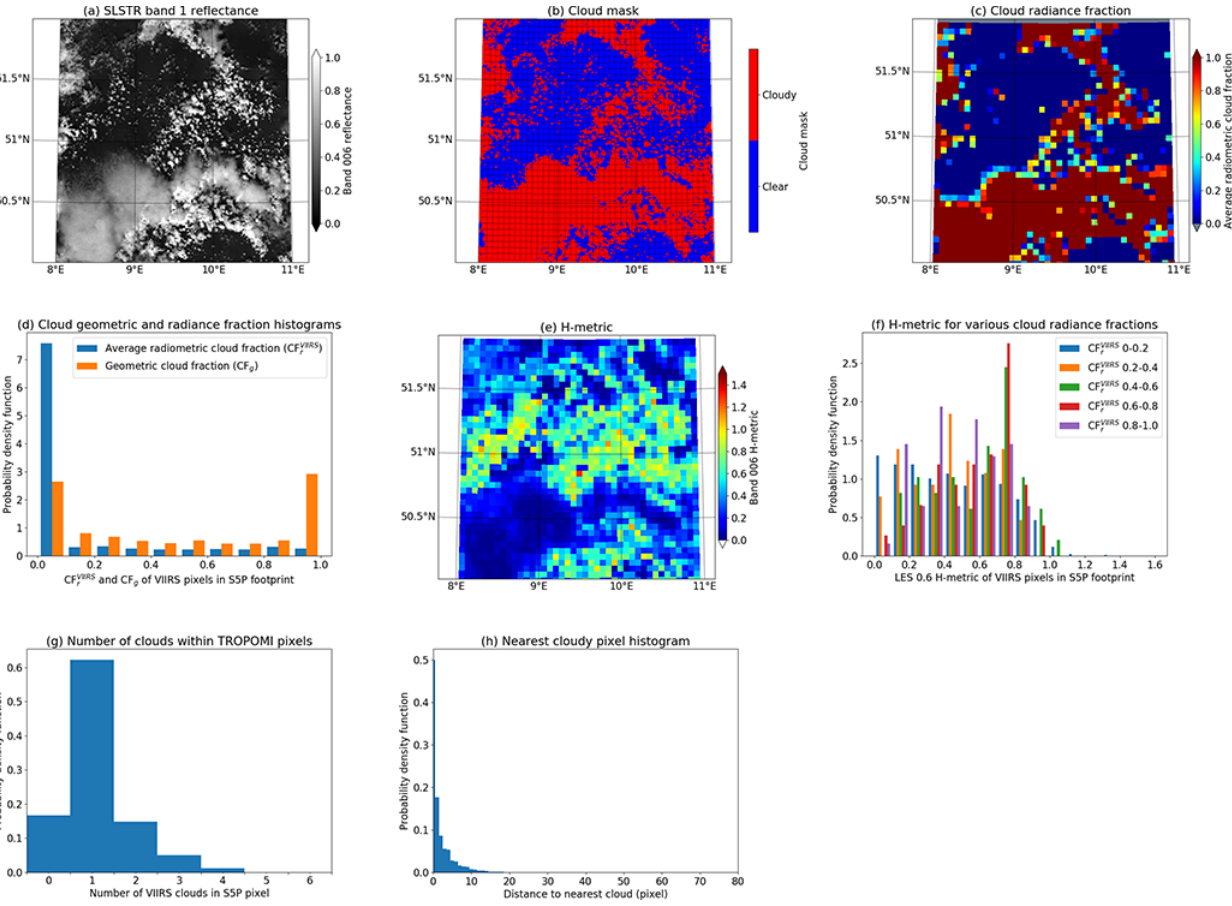
Figure A3. Examples of LES data and cloud metrics for TROPOMI pixels for sub-region 02_02. (a) Simulated SLSTR band 1 reflectance. (b) LES cloud mask with TROPOMI grid overlaid. (c) Cloud radiance fraction for TROPOMI pixels. (d) Distribution of cloud geometric and radiance fractions. (e) H metric for TROPOMI pixels. (f) Distribution of H metric for various cloud radiance fractions. (g) Distribution of number of clouds within TROPOMI pixels. (h) Distribution of distance to nearest cloudy pixel.